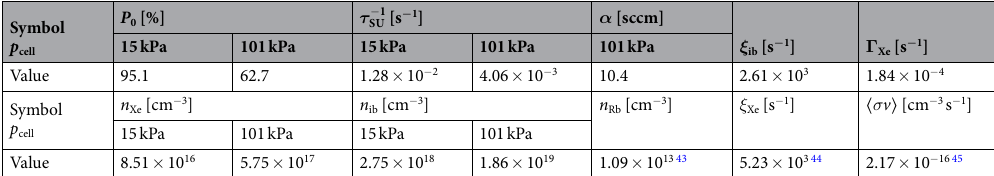
Table 3. Parameters estimated from the analysis of the total gas flow dependence of P Xe using 3% Xe/97% isobutene mixture polarized at 15 kPa and 101 kPa (upper). Number densities of atoms and spin exchange parameters used in the estimation of ξ ib and Γ Xe (lower). The number densities were calculated for 3% Xe/97% isobutene mixture in SEOP cell at a temperature of 383 K and total pressure of 15 kPa and 101